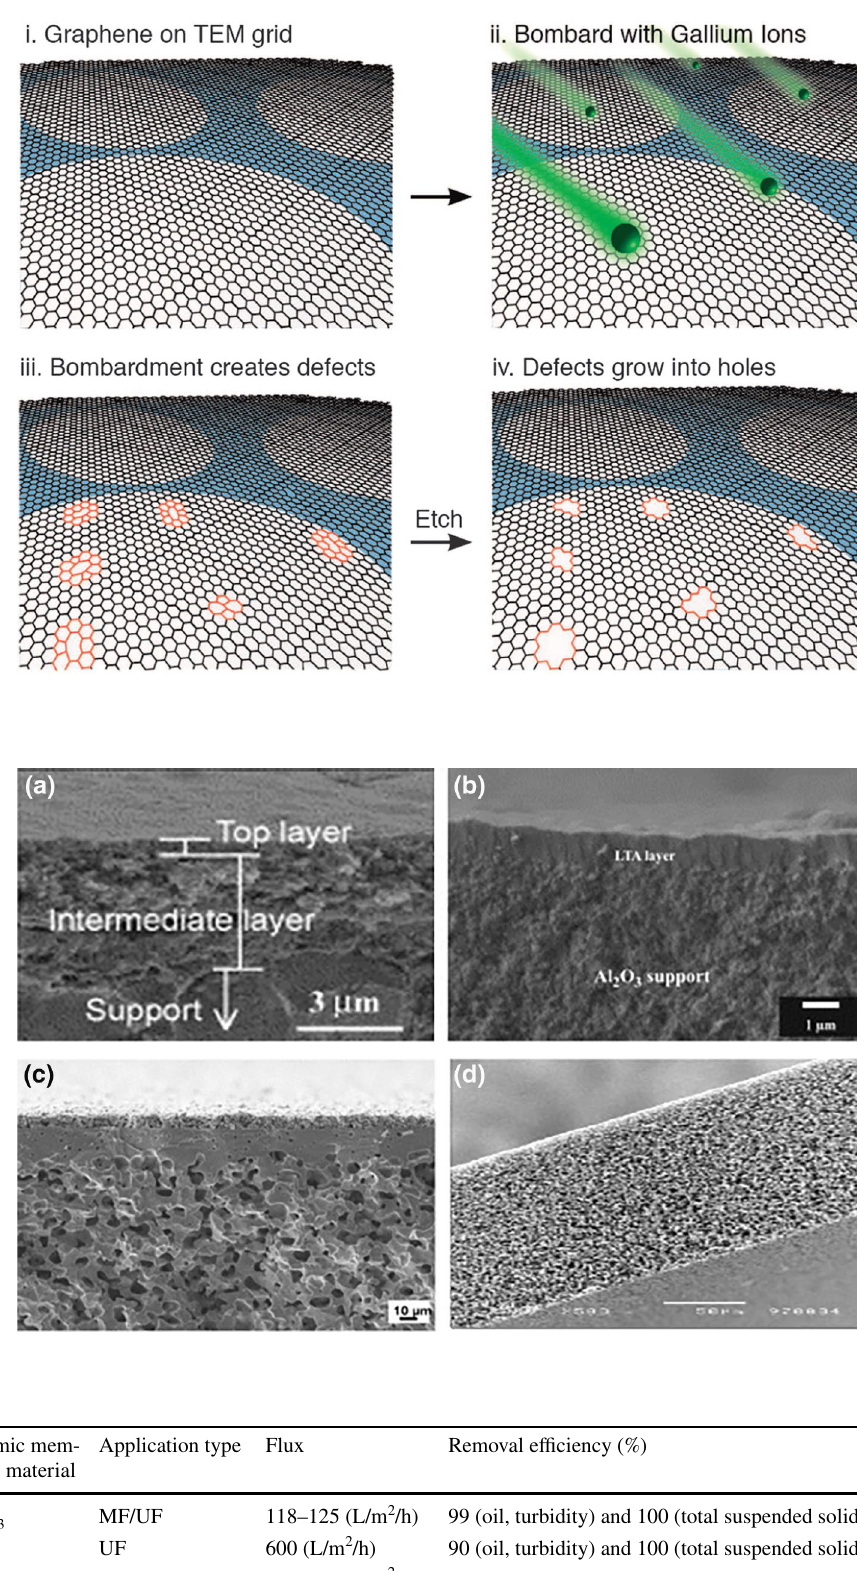
Fig. 4 Schematic illustrating the process for the inclusion of controlled pores in a monolayer graphene membrane by ion bombardment followed by chemical oxidation (Homaeigo- har and Elbahri 2017)